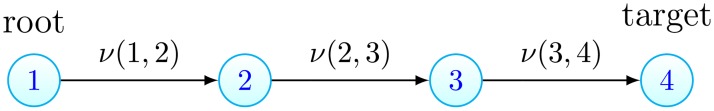
A path graph of length 3, with N = 4.